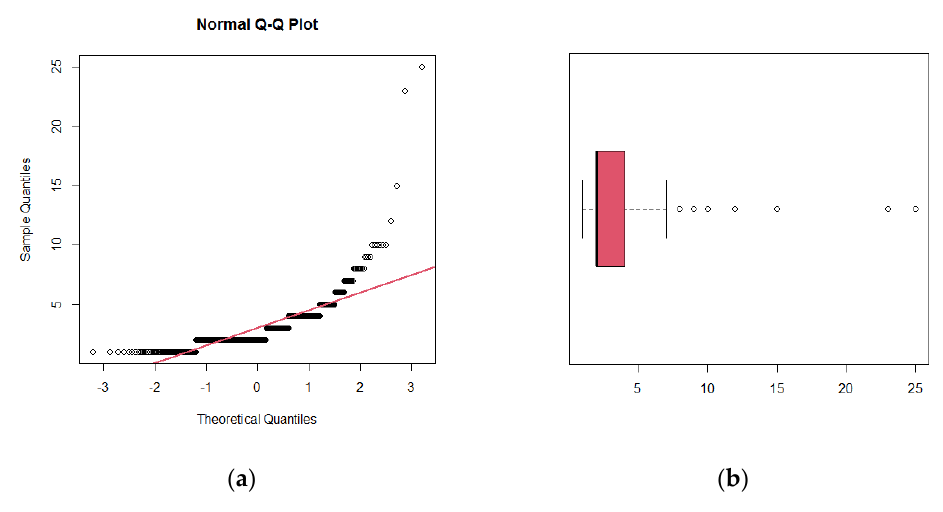
Figure 7. ( a ) QQ plot and ( b ) box for the given data.